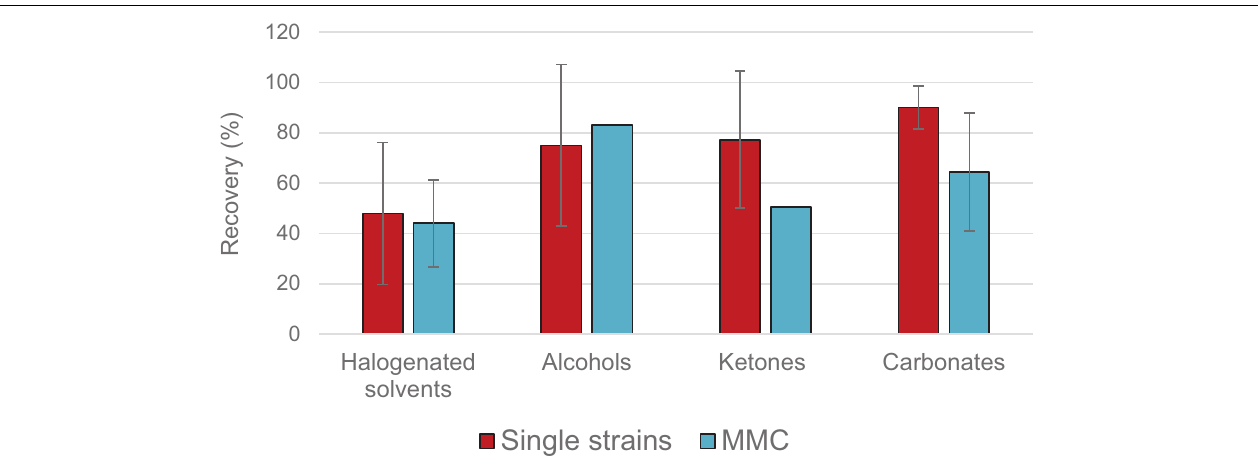
FIGURE 4 | Mean recovery (%) of PHA extracted with solvents (halogenated solvents, alcohols, ketones, and carbonates) from single strains or MMC.